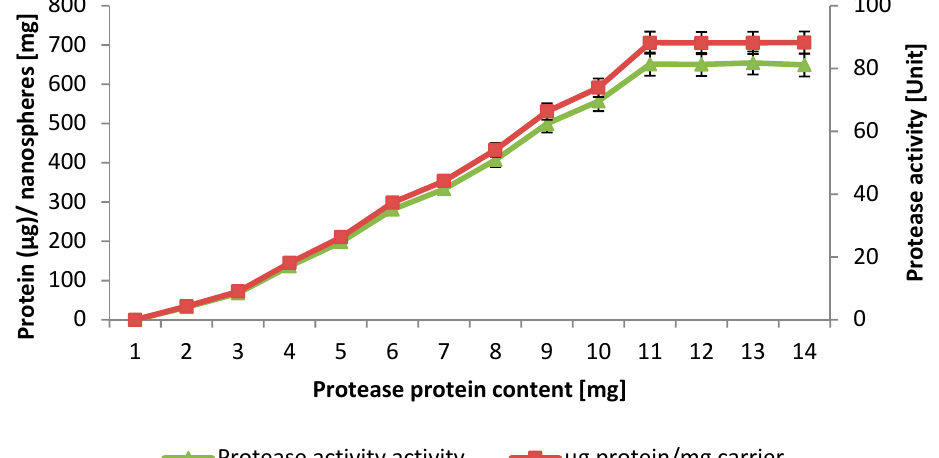
Figure 5. Loading efficiency of hollow core-mesoporous shell silica nanospheres for immobilization of NPST-AK15 protease.